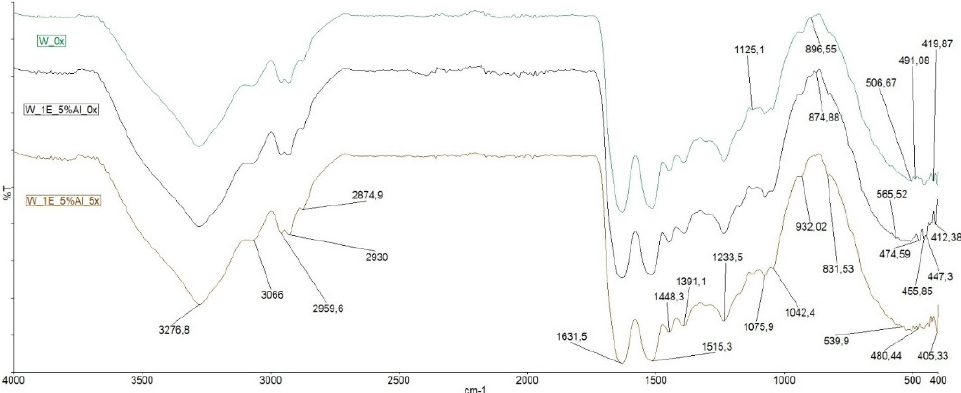
Figure 8. FTIR spectra of wool fabrics, where W_0x is reference fabric, W_1E_5%Al_0x is pre- mordant with 5% alum, dyed and unwashed wool fabric and W_1E_5%Al_5x is the same sample as previous but after 5 washing